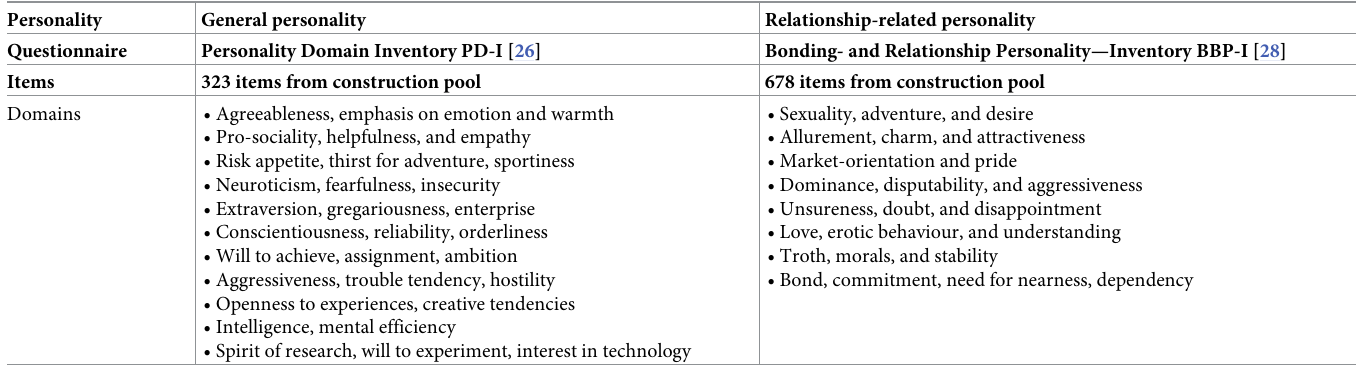
Table 1. Operationalization of personality variables at T1 with content